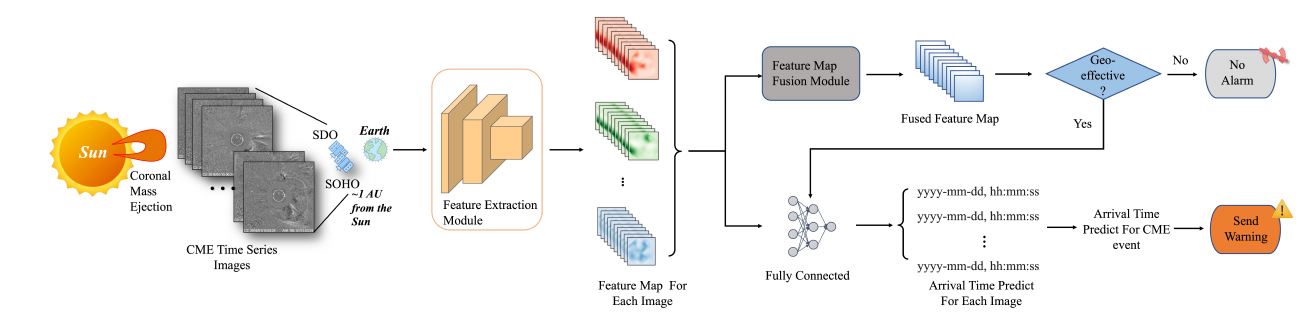
Figure 1. The overall deep learning framework of jointing geoeffectiveness and arrival time prediction. In the framework, we first predict the geoeffectiveness of CMEs and for geoeffective CMEs, we further predict the arrival